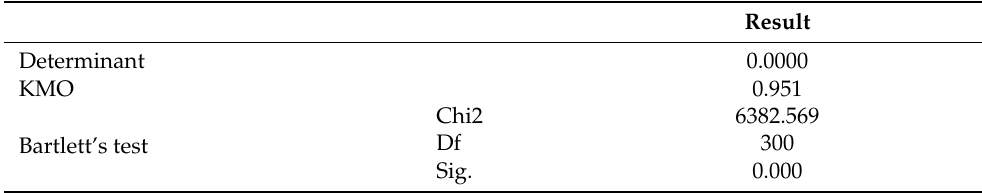
Table 5. KMO and Bartlett’s test of sphericity.